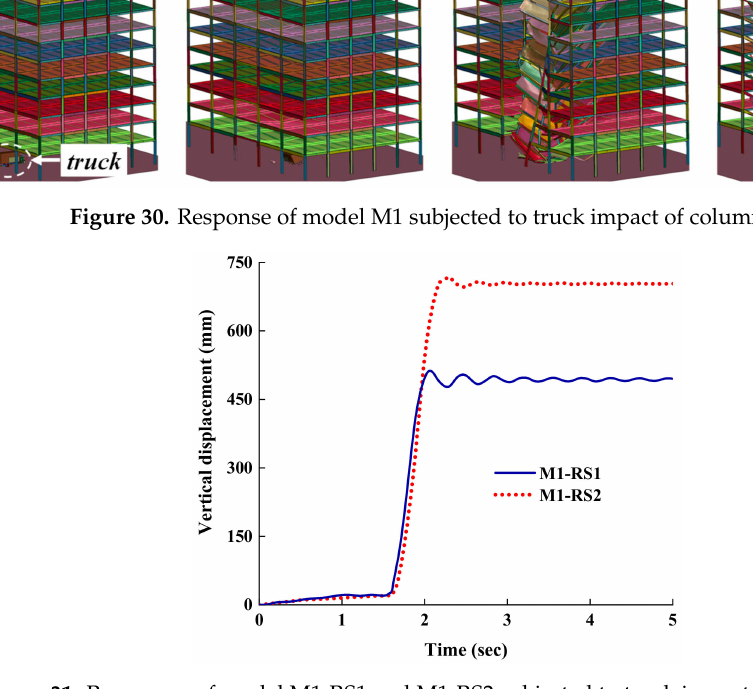
Figure 31. Responses of model M1-RS1 and M1-RS2 subjected to truck impact of column